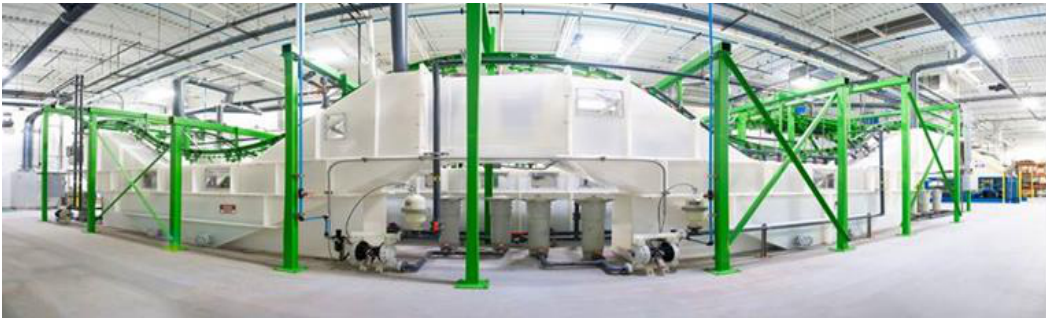
Figure 2. First Solar high-value PV recycling facility recovering glass and semiconductors with >90% yield.